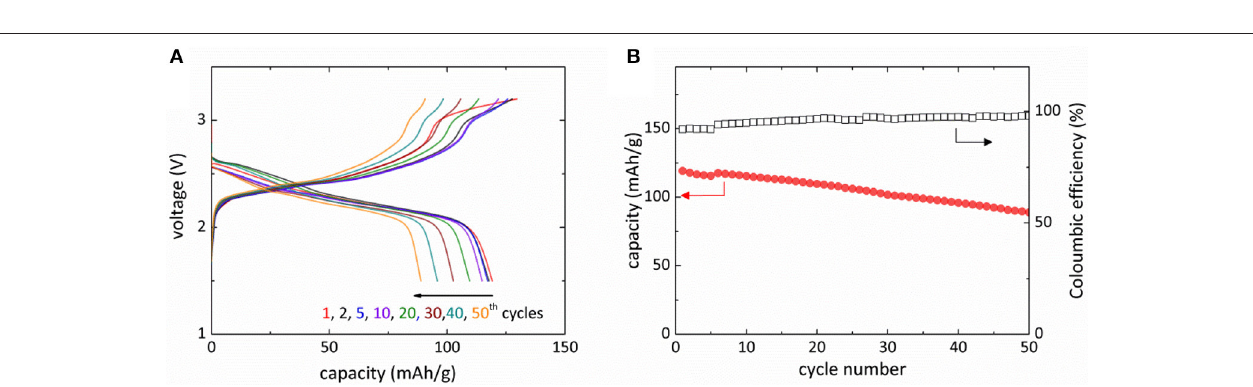
FIGURE 3 | Electrochemical performance of Mg-NaCrO 2 hybrid battery. (A) Voltage profile for the charge and discharge of Mg-NaCrO 2 hybrid battery. (B) Discharge capacity and coulombic efficiency during the first 50 cycles.